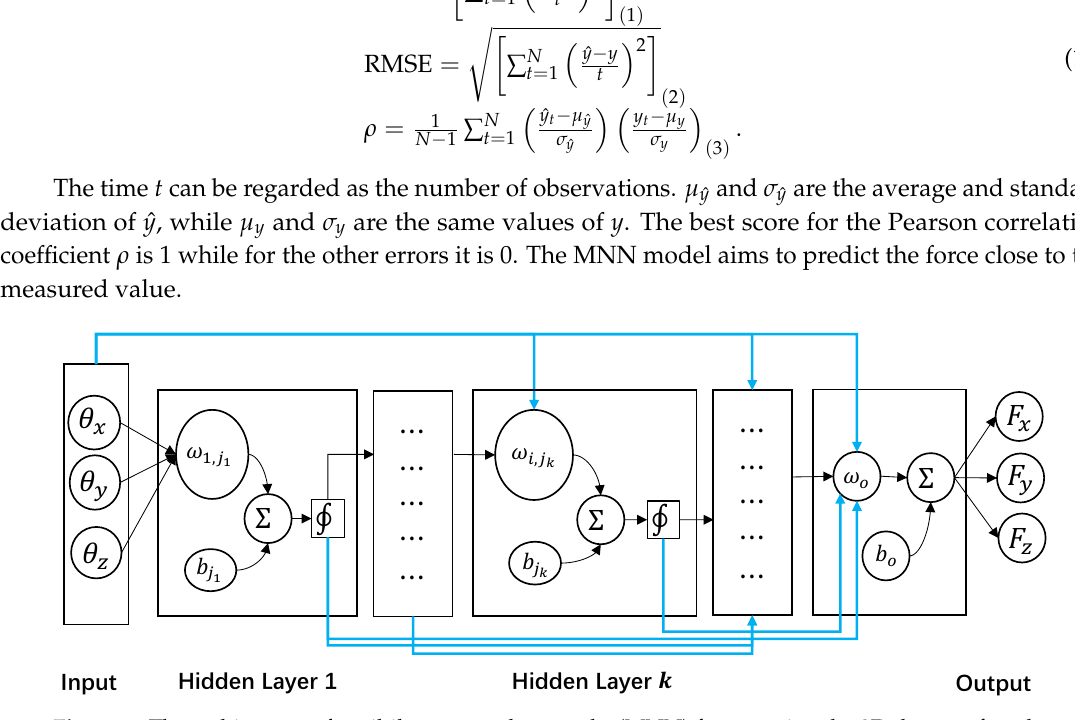
Figure 4. The architecture of muiltilayer neural networks (MNN) for mapping the 3D degree of angles [ θ x , θ y , θ z ] and 3D forces [ F x , F y , F z ] . The feed-forward (FF)-MNN model is shown by all of the black lines, while the cascade-forward (CF)-MNN model connects the outputs of each previous layers to the current layer (shown with blue